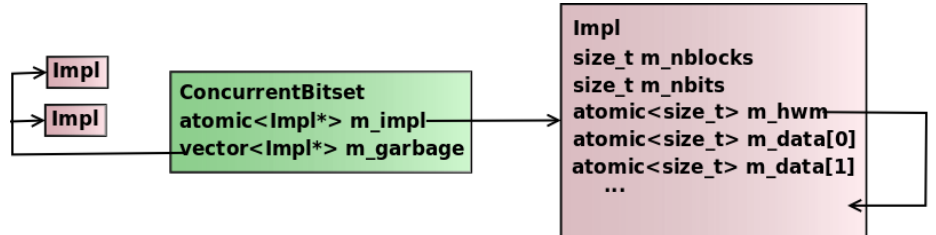
Figure 2. A ConcurrentBitset object points to a (variable-sized) implementation object, which contains an array of words containing the data, along with housekeeping information. If the array needs to grow, a new implementation object is allocated and the old one added to the m_garbage list, to be deleted along with the ConcurrentBitset itself.